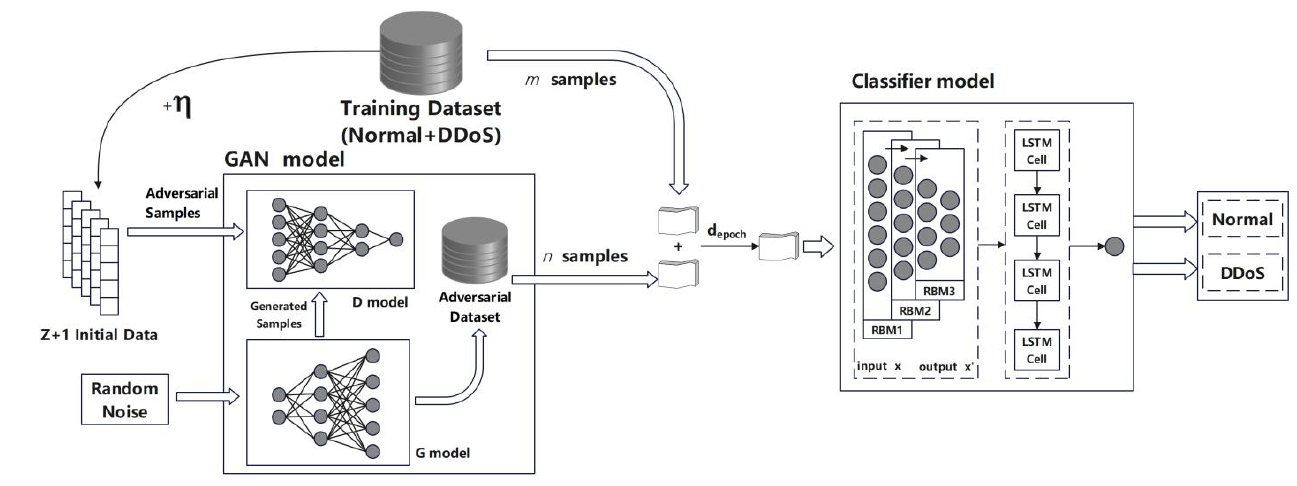
Figure 3. Adversarial DBN-LSTM training structure.